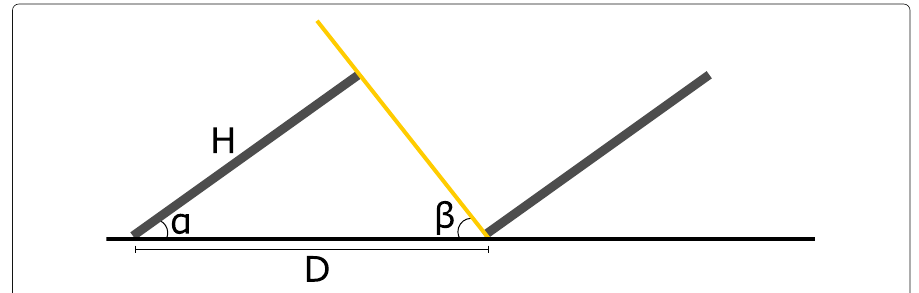
the self-discharge coefficient α , and the charge/discharge efficiency η CHA , DIS . In order to replicate the cyclicity of the operation, the initial amount and final amount of energy stored in the battery are fixed by Eqs. 7 and 8 with SOC 0 the initial state of charge. The battery should operate within the given bounds of the state of charge SOC min and SOC max